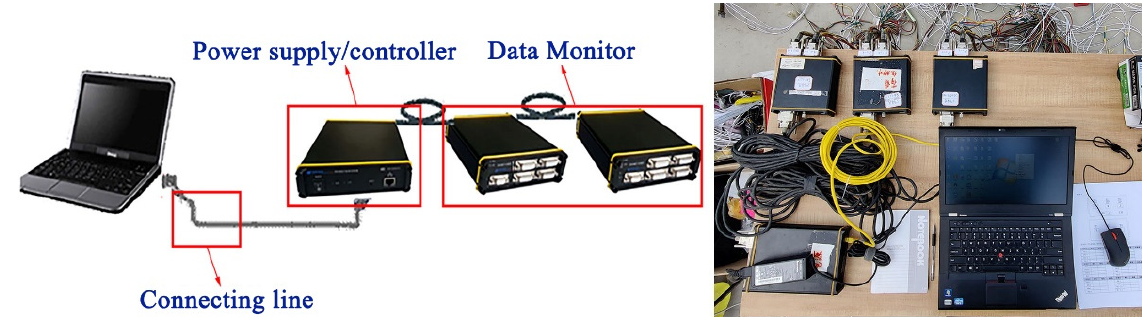
Figure 6. Static DH3821 high-speed static strain measurement and analysis system.